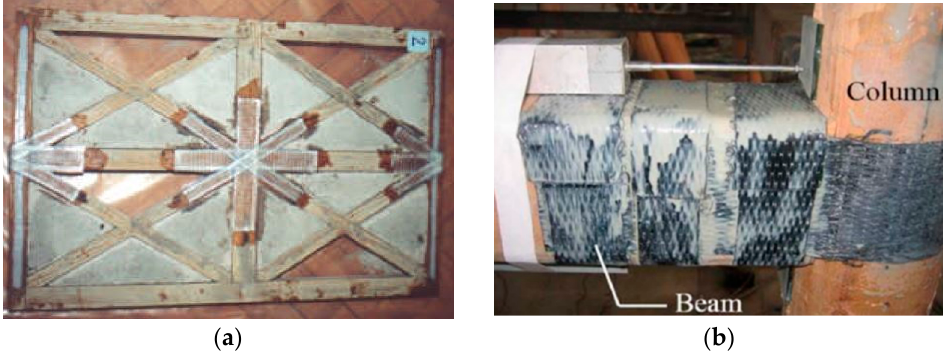
Figure 16. ( a ) Retrofitted timber frame walls with GFRP strips [115], and ( b ) a post and beam con- nection strengthened by CFRP strips